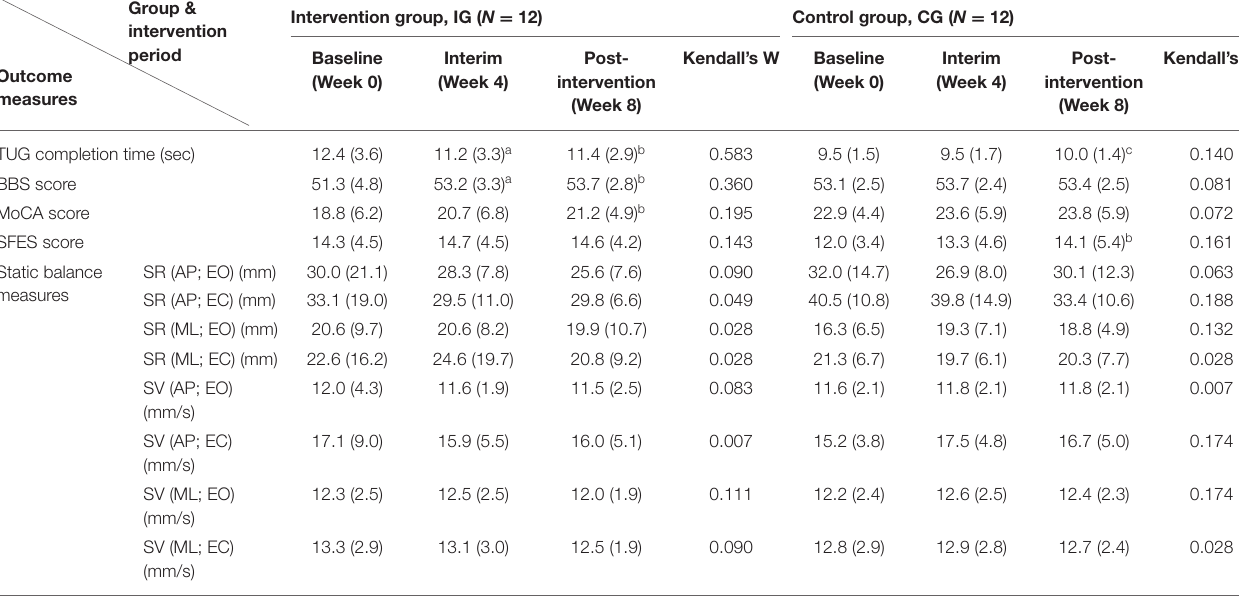
TABLE 4 | Performance outcomes (mean, standard deviation in bracket) of the intervention group and the control group at baseline, interim, and post-intervention, and results of Friedman tests and post-hoc analyses.